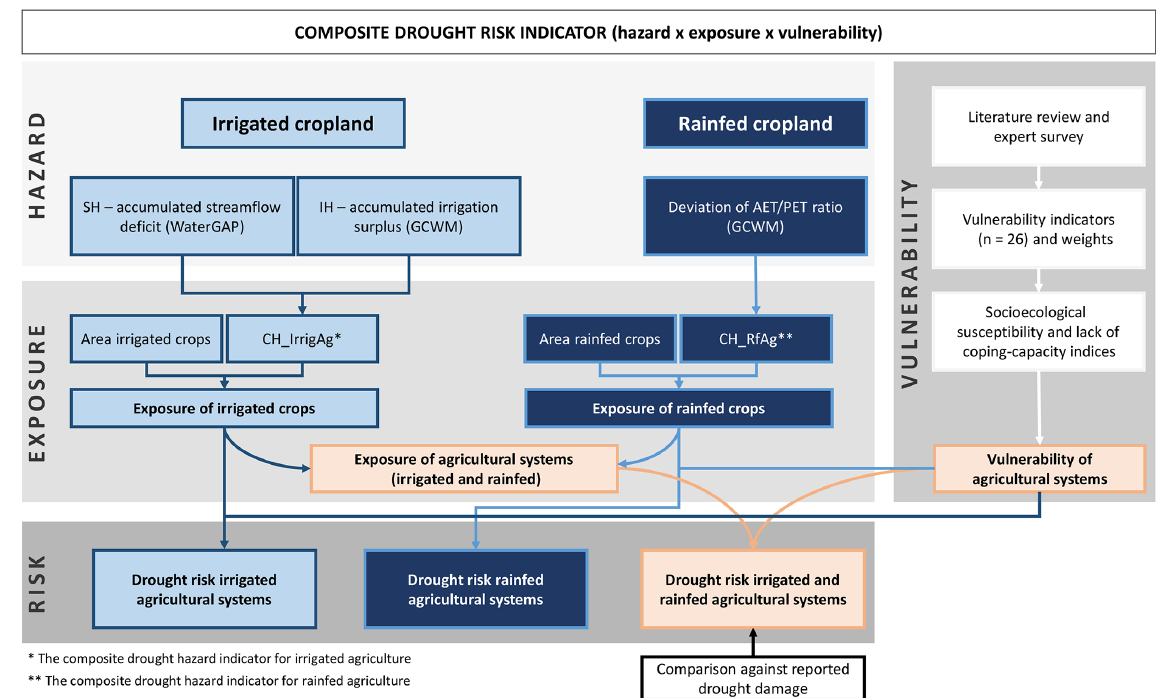
Figure 1. Workflow for the overall global drought risk assessment for agricultural systems (including irrigated and rainfed